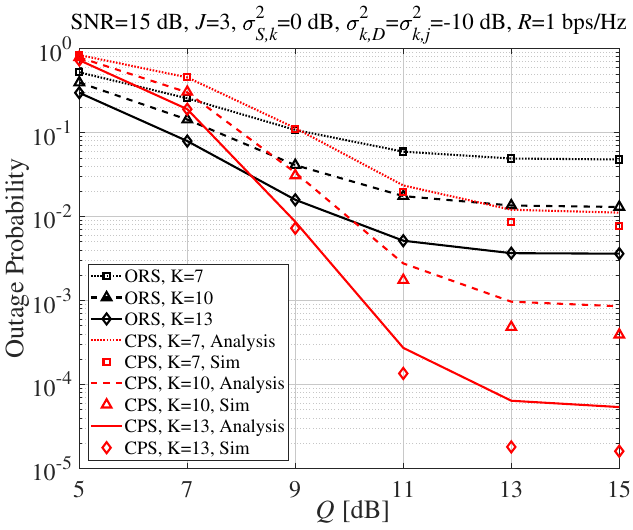
Figure 4. Outage probability according to Q